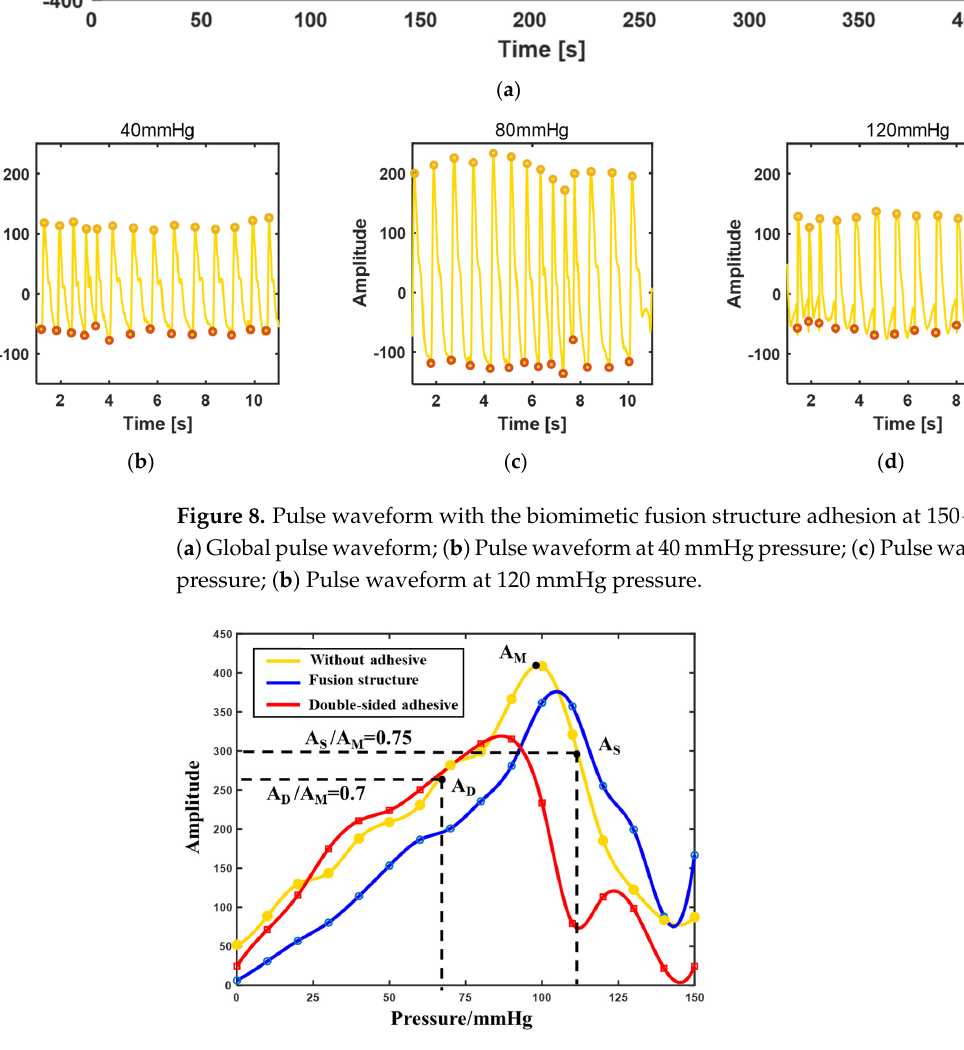
Figure 8. Pulse waveform with the biomimetic fusion structure adhesion at 150 − 0 mmHg pressure: ( a ) Global pulse waveform; ( b ) Pulse waveform at 40 mmHg pressure; ( c ) Pulse waveform at 80 mmHg pressure; ( b ) Pulse waveform at 120 mmHg pressure.